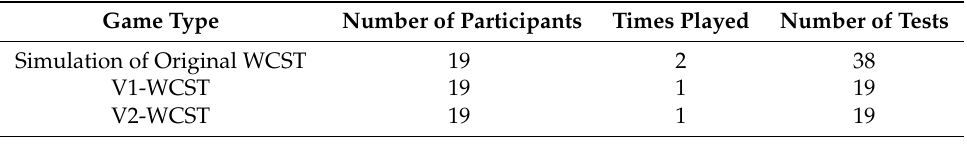
Table 1. Total number of WCST tasks included in the CogBeacon